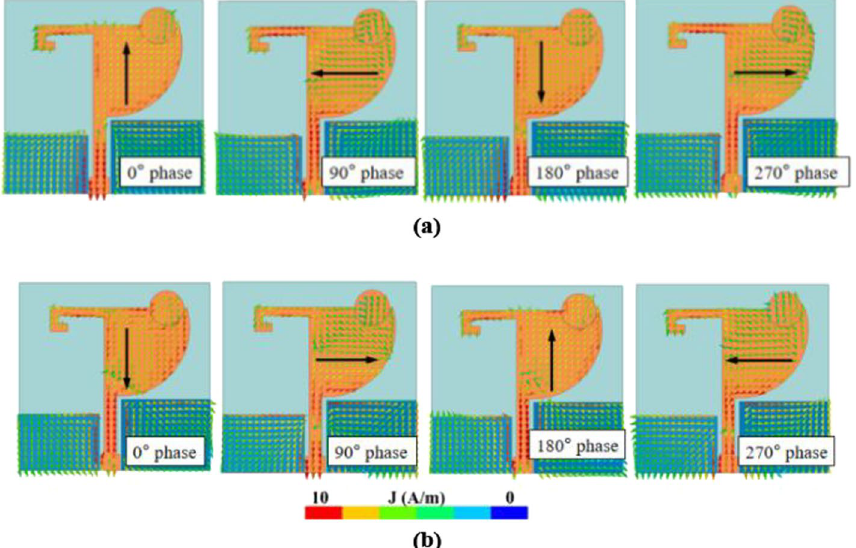
Fig. 4 Distributions of surface currents on the proposed antennas at a 6.5. b 8.5